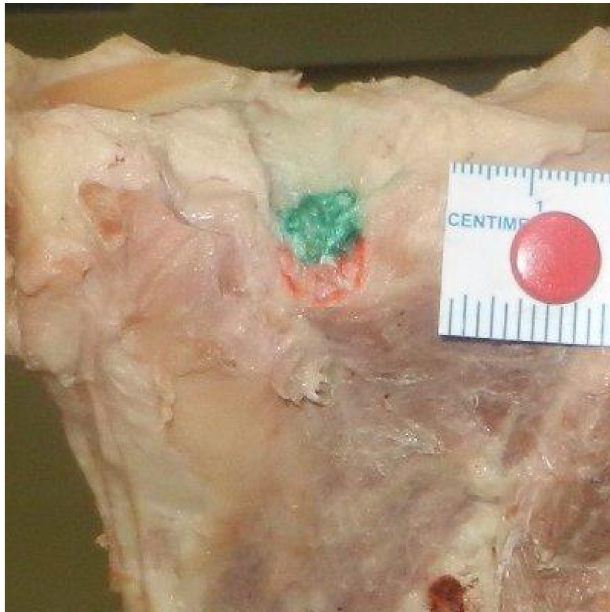
Figure 1. Footprint of PCL on tibia before bone resection. Antero-lateral bundle is marked with green and postero-medial bundle with red.